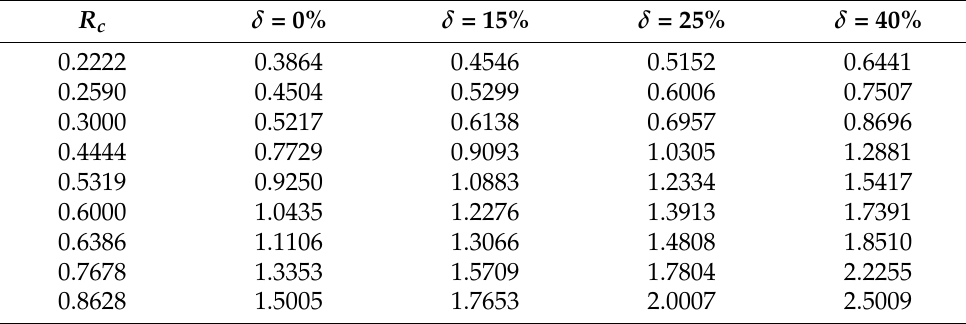
Table 4. Maximum achievable throughput in terms of the overlapping factor and code